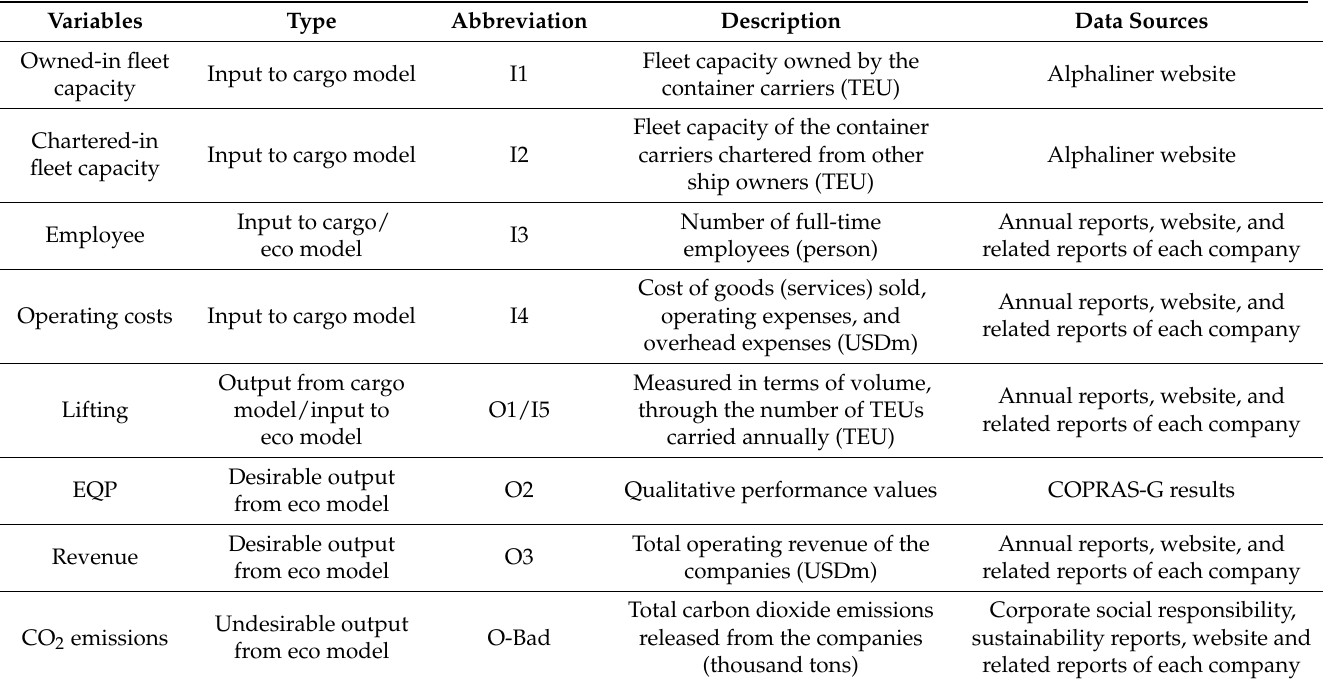
Figure 6. Efficiency models of CSCs. Table 14. Description of input and output variables.